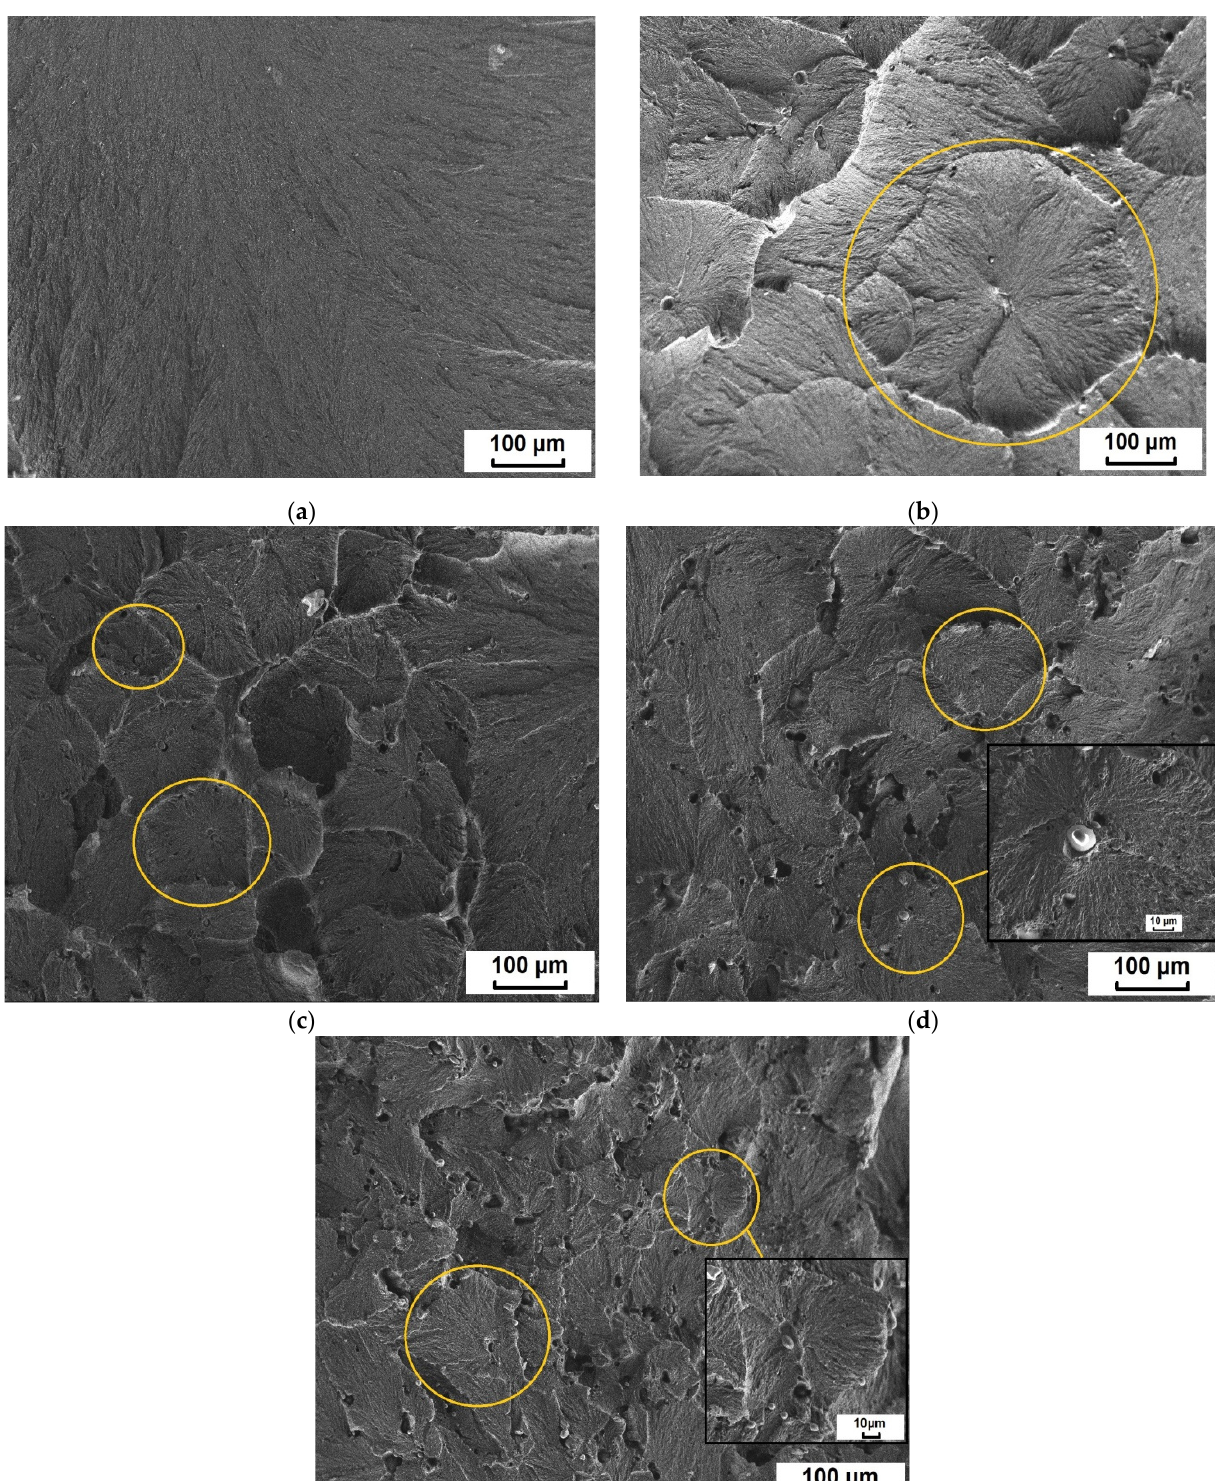
Figure 5. Microphotographs of the structure of ( a ) the initial ultra-high-molecular weight polyethylene (UHMWPE) and polymer composite materials (PCMs) based on UHMWPE filed by BP ( b ) 0.5 wt. %, ( c ) 1.0 wt. %, ( d ) 2.0 wt. % and ( e ) 5.0 wt. %.